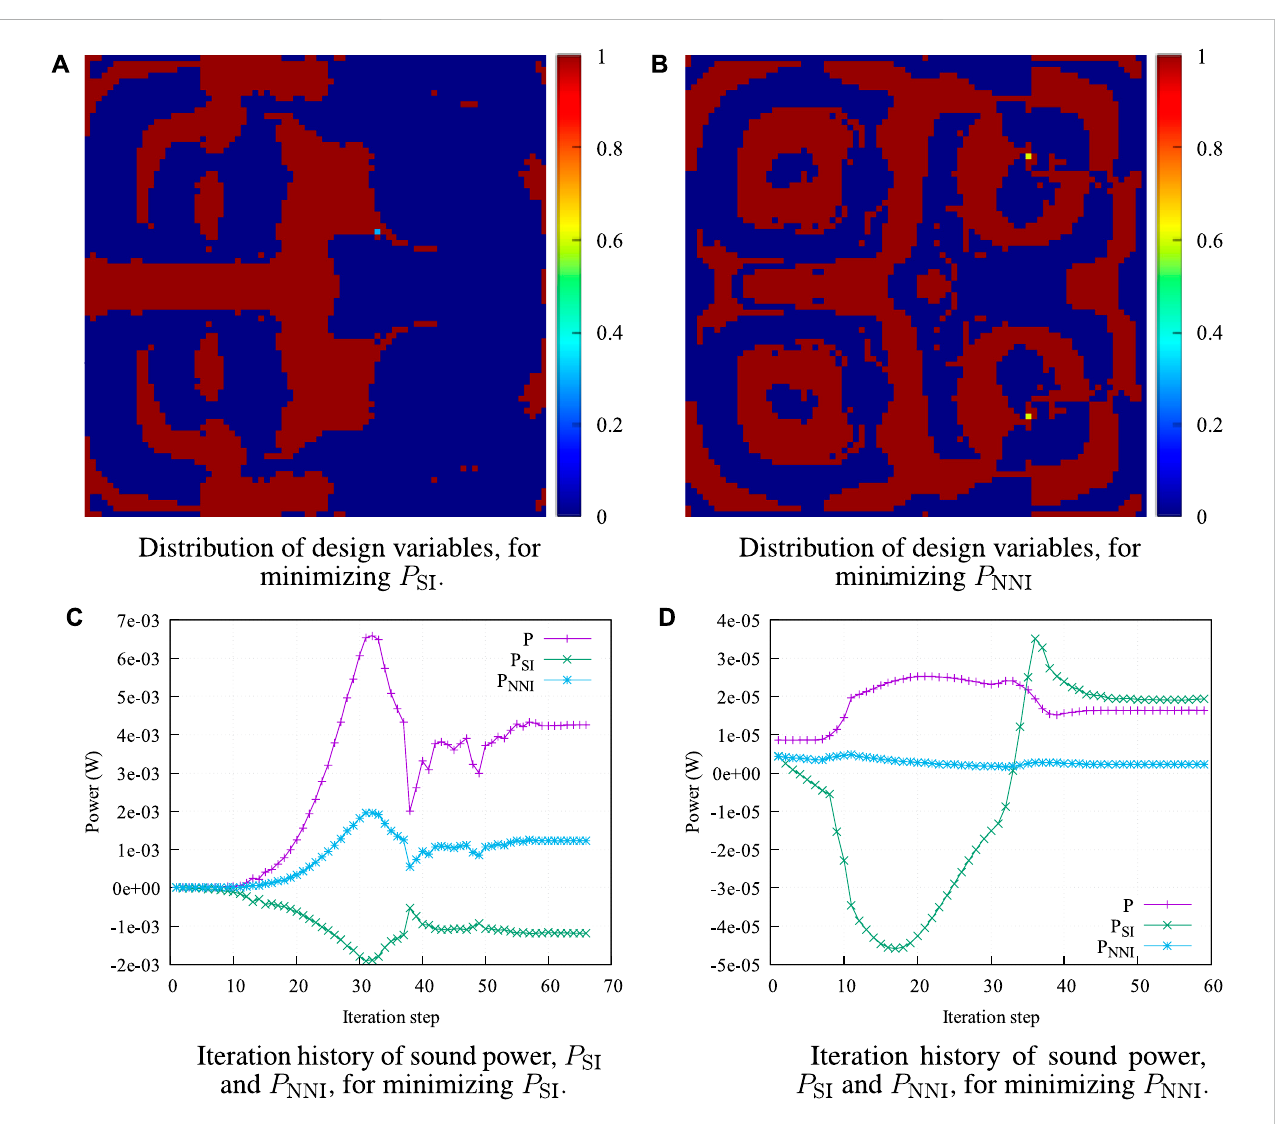
FIGURE 9 Optimization results of P SI and P NNI . The left parts are chosen as the investigated surface Γ c . (A) Distribution of design variables, for minimizing P SI . (B) Distribution of design variables, for minimizing P NNI . (C) Iteration history of sound power, P SI and P NNI , for minimizing P SI . (D) Iteration history of sound power, P P P SI and NNI , for minimizing SI